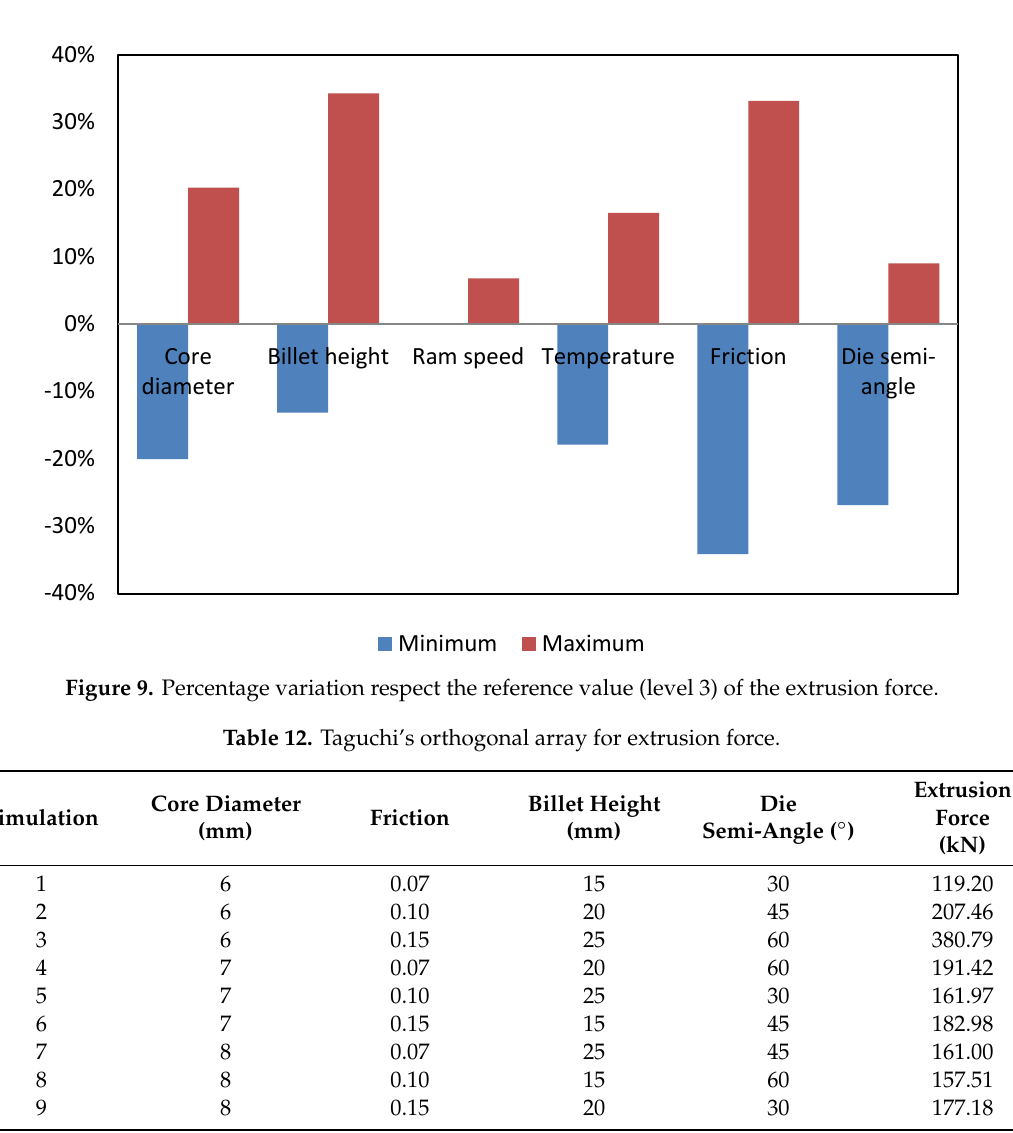
Table 13. Taguchi’s results for the average values for extrusion force